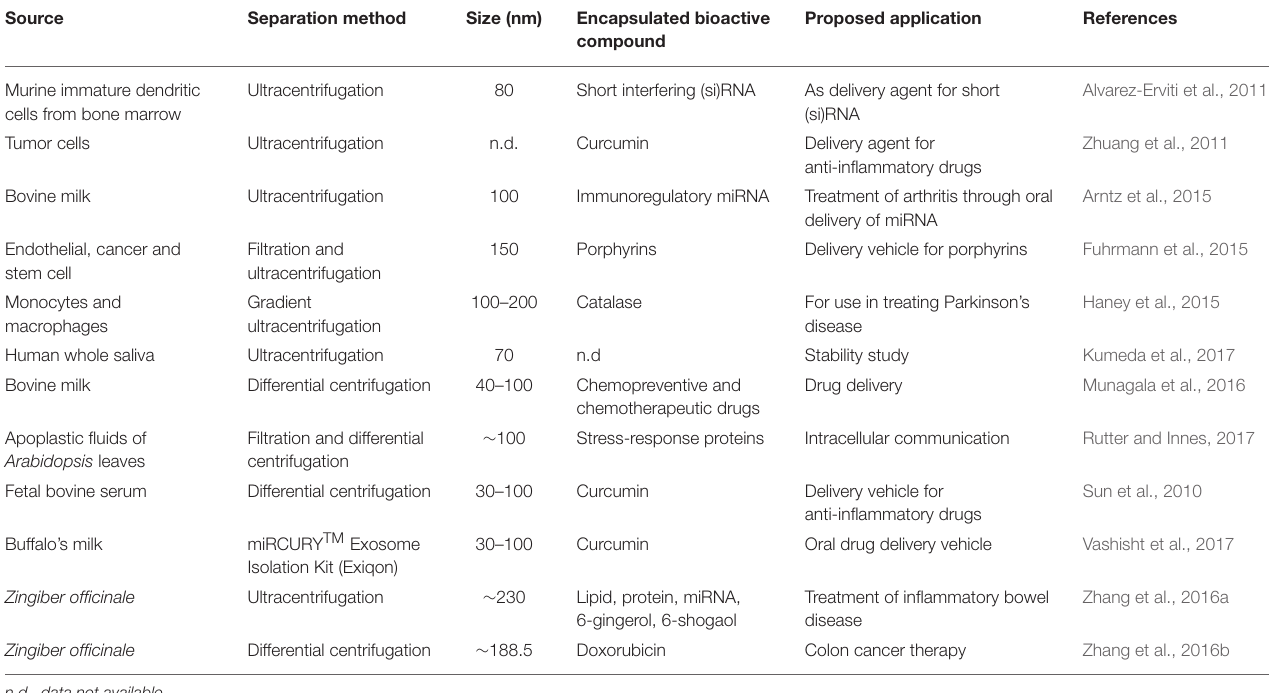
TABLE 1 | Sources, extraction, and proposed application of exosome vesicles in the delivery of functional and bioactive molecules.